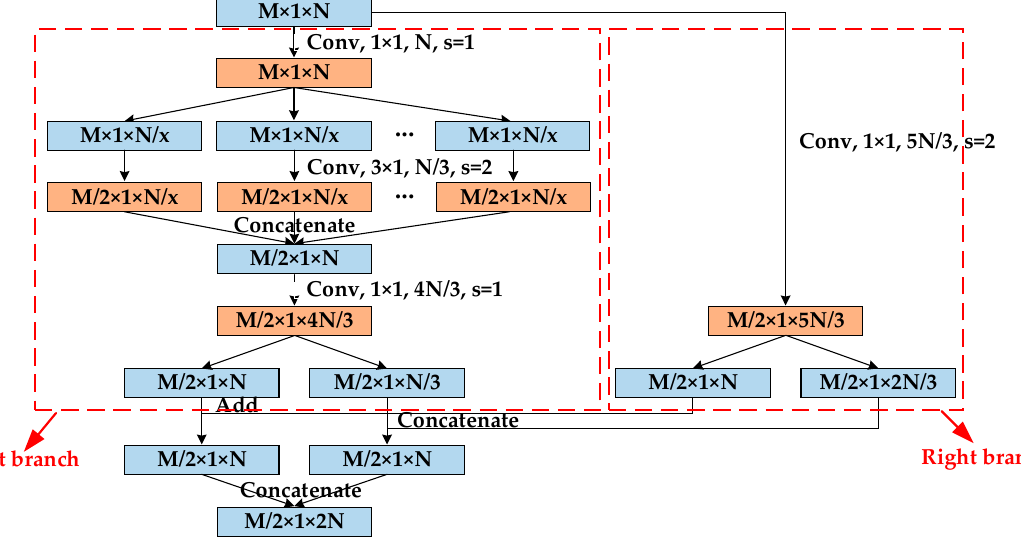
Figure 3. Structure of the convolutional module. M × 1 × N represents one-dimensional data with input characteristics of M × 1, N feature layers, s is the moving step size of the convolution kernel, and the unmarked step size is 1 by